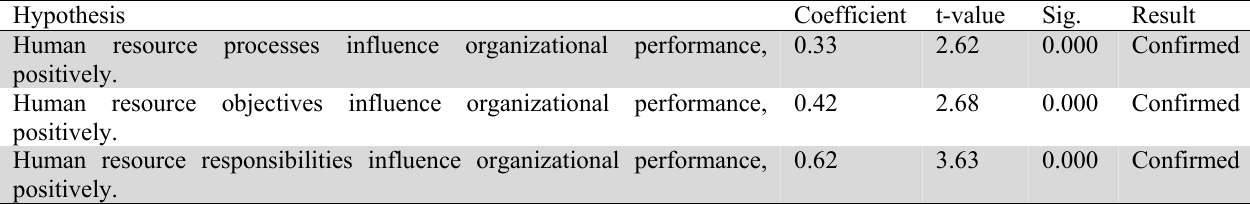
Hypothesis Coefficient t-value Sig. Result Human resource processes influence organizational performance, positively. Human resource objectives influence organizational performance, positively. Human resource responsibilities influence organizational performance,